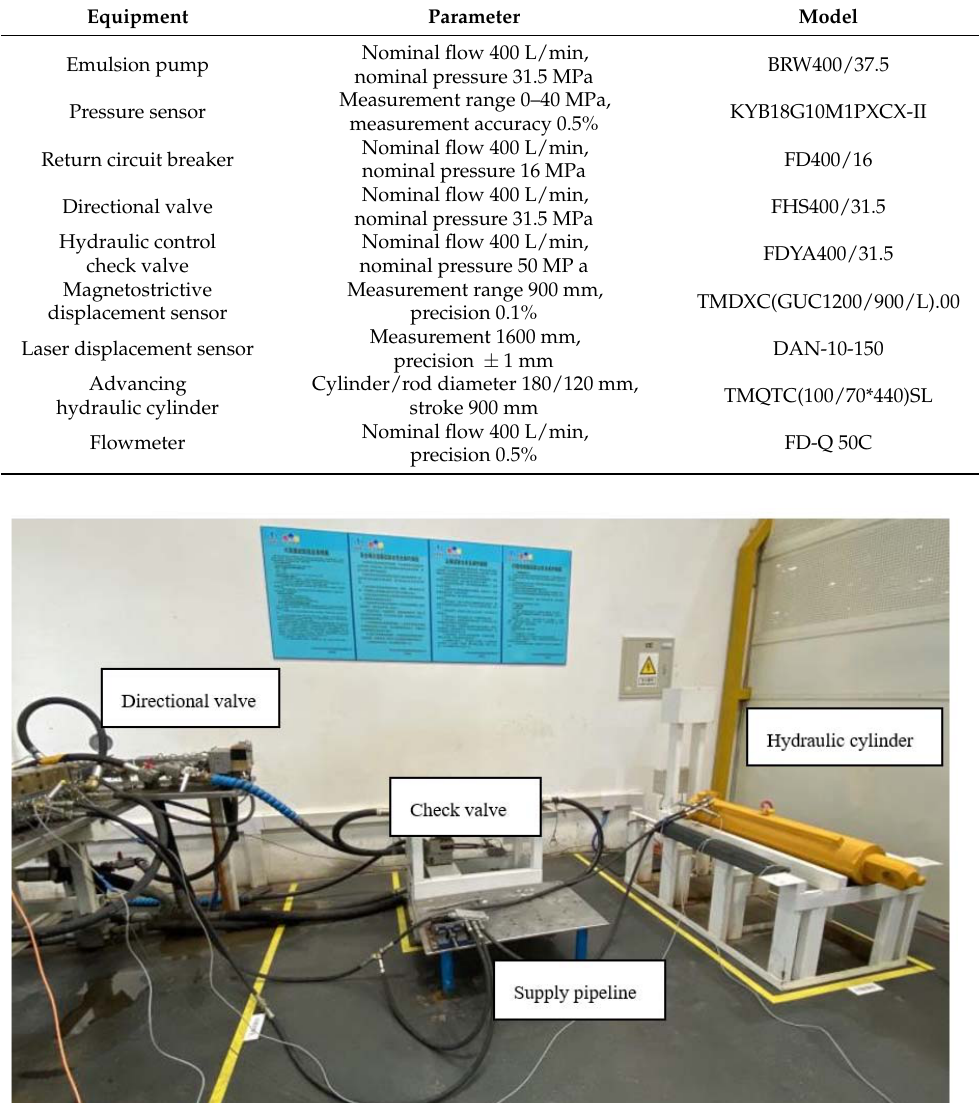
Table 2. Parameters of experimental equipment.